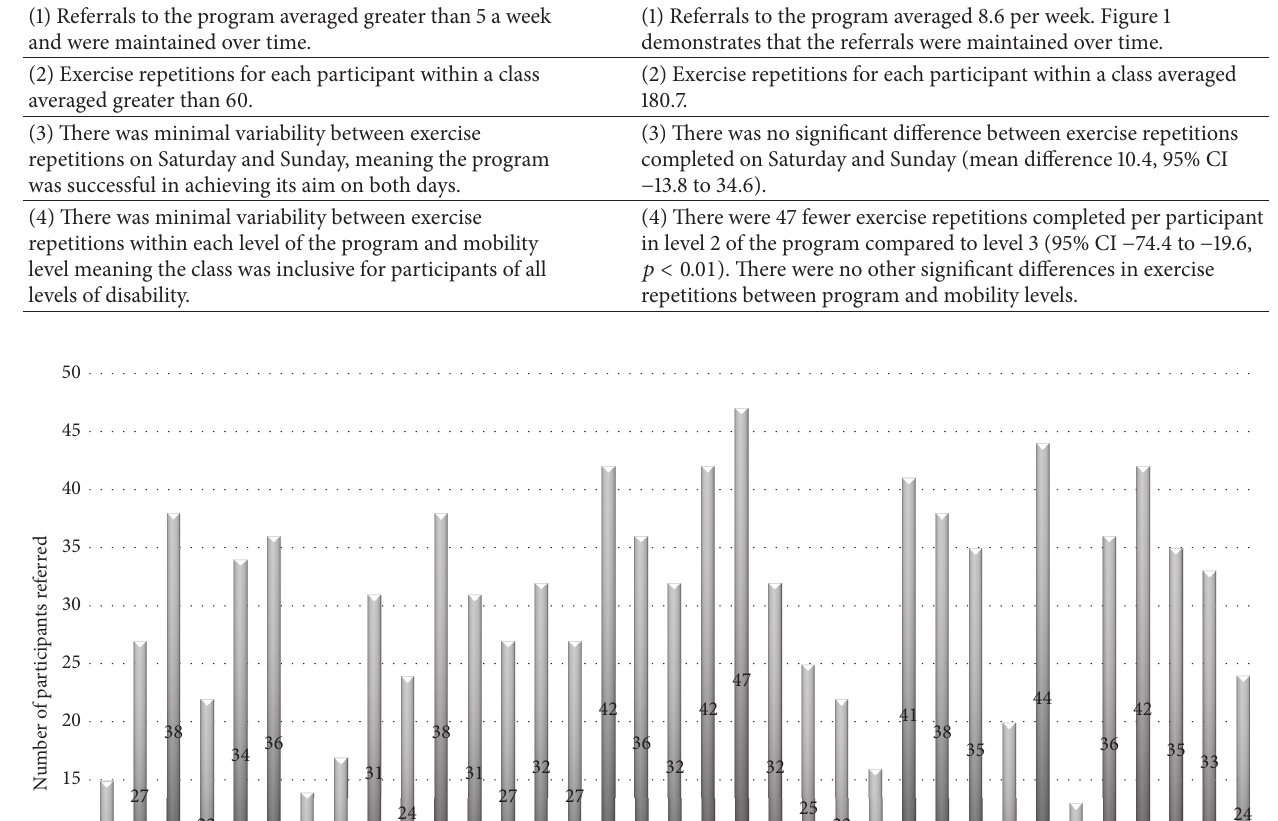
Table 5: Comparison of the study results to the predetermined feasibility criteria. Predetermined feasibility criteria Study results